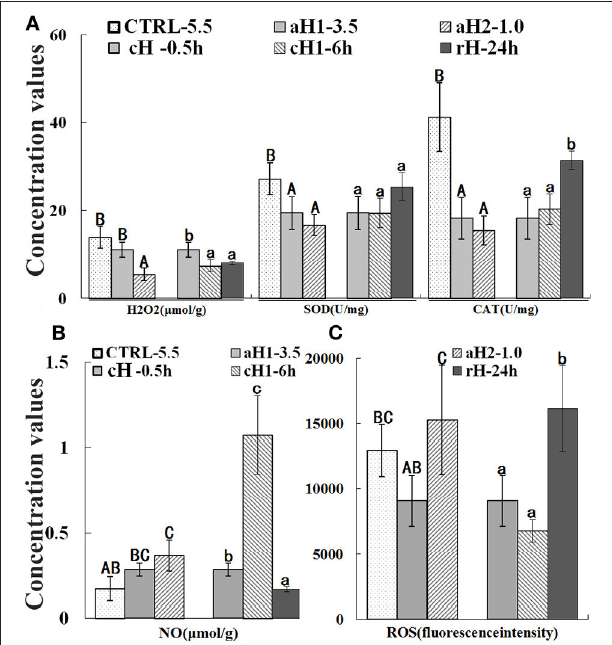
FIGURE 3 | Hydrogen peroxide (H 2 O 2 ) concentration, superoxide dismutase (SOD), and catalases (CAT) activity (A) , nitric oxide (NO) concentration (B) , and total reactive oxygen species (ROS) (C) in M. amblycephala liver after hypoxia treatment. Three different DO level groups are individually analyzed and indicated with capital letters, while three hypoxia time condition groups are also separately analyzed and showed with lowercase letters. Different letters above bars represent significant difference ( p < 0.05), and the same letters above bars indicate no significant difference. Values are mean ± S.D.; N = 5 for every